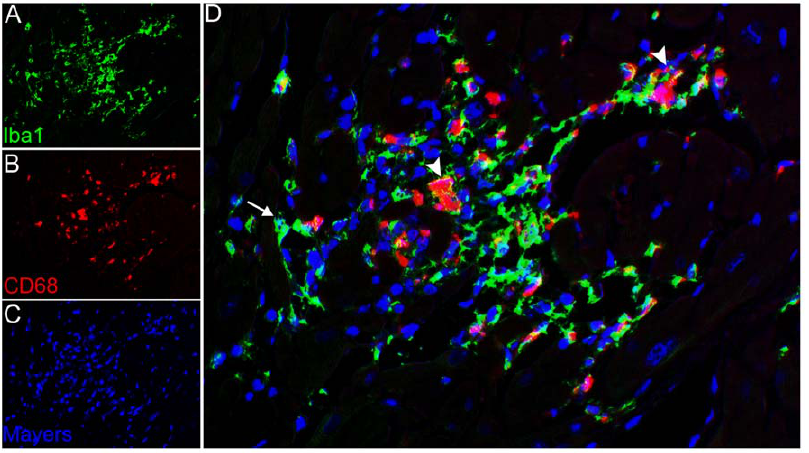
Figure 3. Activated macrophages are localized within inflammatory foci. Multiparameter immunohistochemistry and multispectral imaging to localize the macrophage marker Iba-1 (green) and the activated macrophage marker CD68 (red). Double immunolabeling and spectral imaging with pseudofluorescence coloring identifies Iba-1 expressing macrophages (green) within inflammatory foci (A). Expression of CD68 (red) identifies activated macrophages within inflammatory foci (B). Nuclei are stained with Mayer’s hematoxylin counterstain (blue) (C). Note co-localization of all CD68 expression within Iba-1 expressing cells (D) (arrows) (400X).